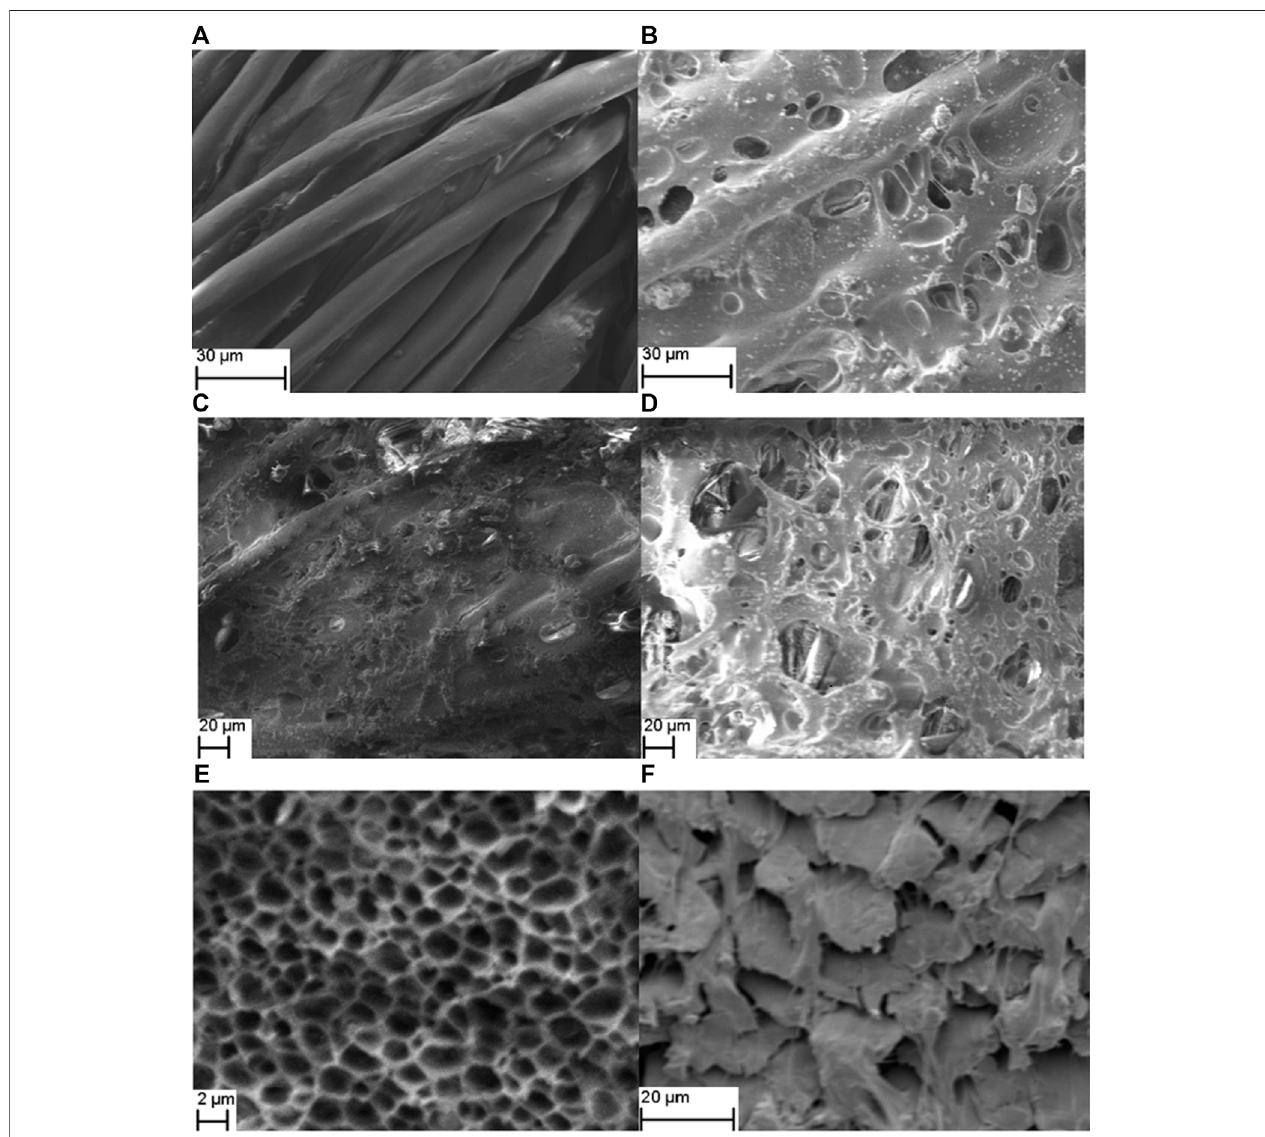
FIGURE 2 | The SEM image of: (A) plan view of the polyester cotton textile. (B) plan view of textile with polymer membrane. (C) plan view of textile with polymer membrane at high magni fi cation. (D) cross-section view of textile with polymer membrane. (E) plan view of textile with polymer membrane (air dried) without phase inversion at lower magni fi cation. (F) plan view of textile with polymer membrane with phase inversion at lower magni fi cation.